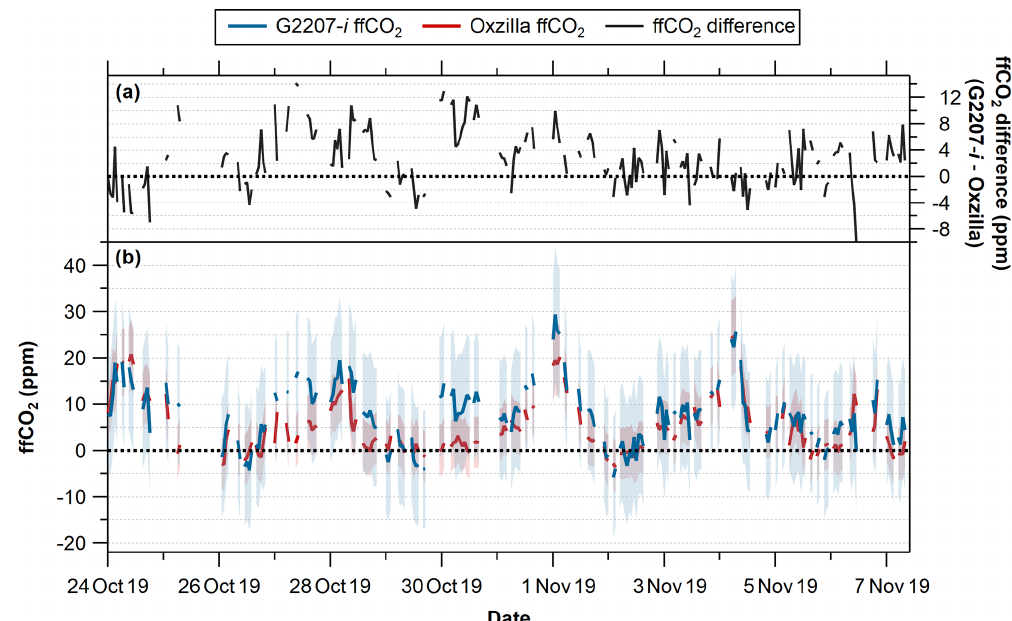
Figure 9. (a) Difference between the ffCO 2 calculated using O 2 from the G2207- i and the Oxzilla (G2207- i – Oxzilla). (b) Calculated ffCO 2 using O 2 from the G2207- i (blue) and the Oxzilla (red); blue and red shaded areas indicate uncertainty of the calculated ffCO 2 . Dashed black lines indicate 0ppm. Negative ffCO 2 values occur when the O 2 observations are above (more positive than) the calculated O 2 baseline. Note that gaps are due to the threshold requirement of a minimum of 20min of data for hourly